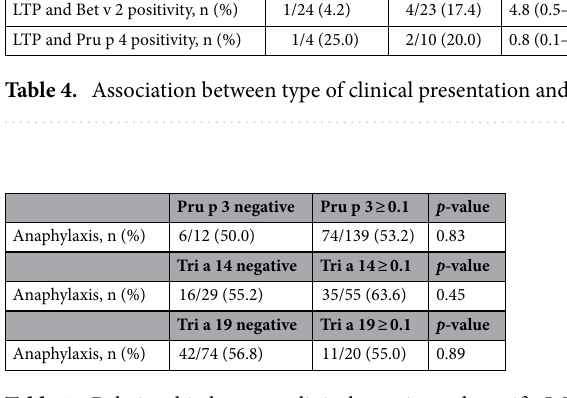
Table 5. Relationship between clinical severity and specific IgE